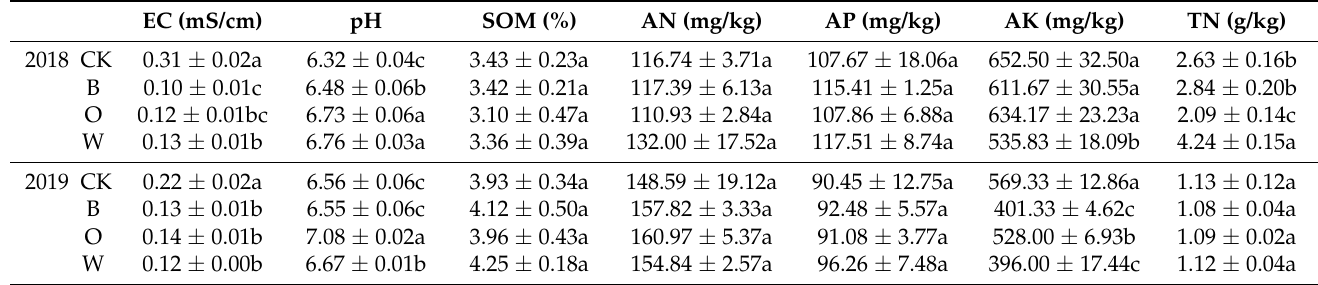
Table 1. Effects of different preceding crops on soil chemical properties.